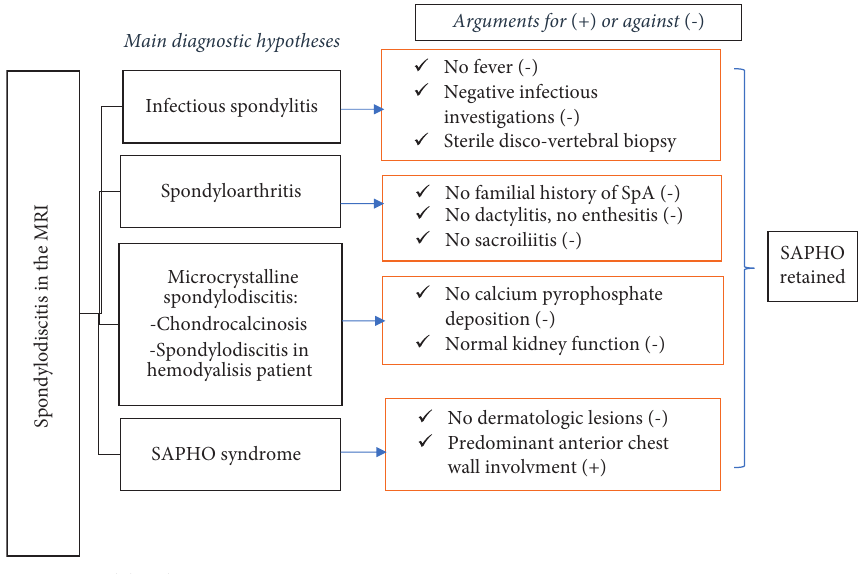
Figure 4: Summary diagram of case 2 diagnosis. SpA: spondyloarthritis.